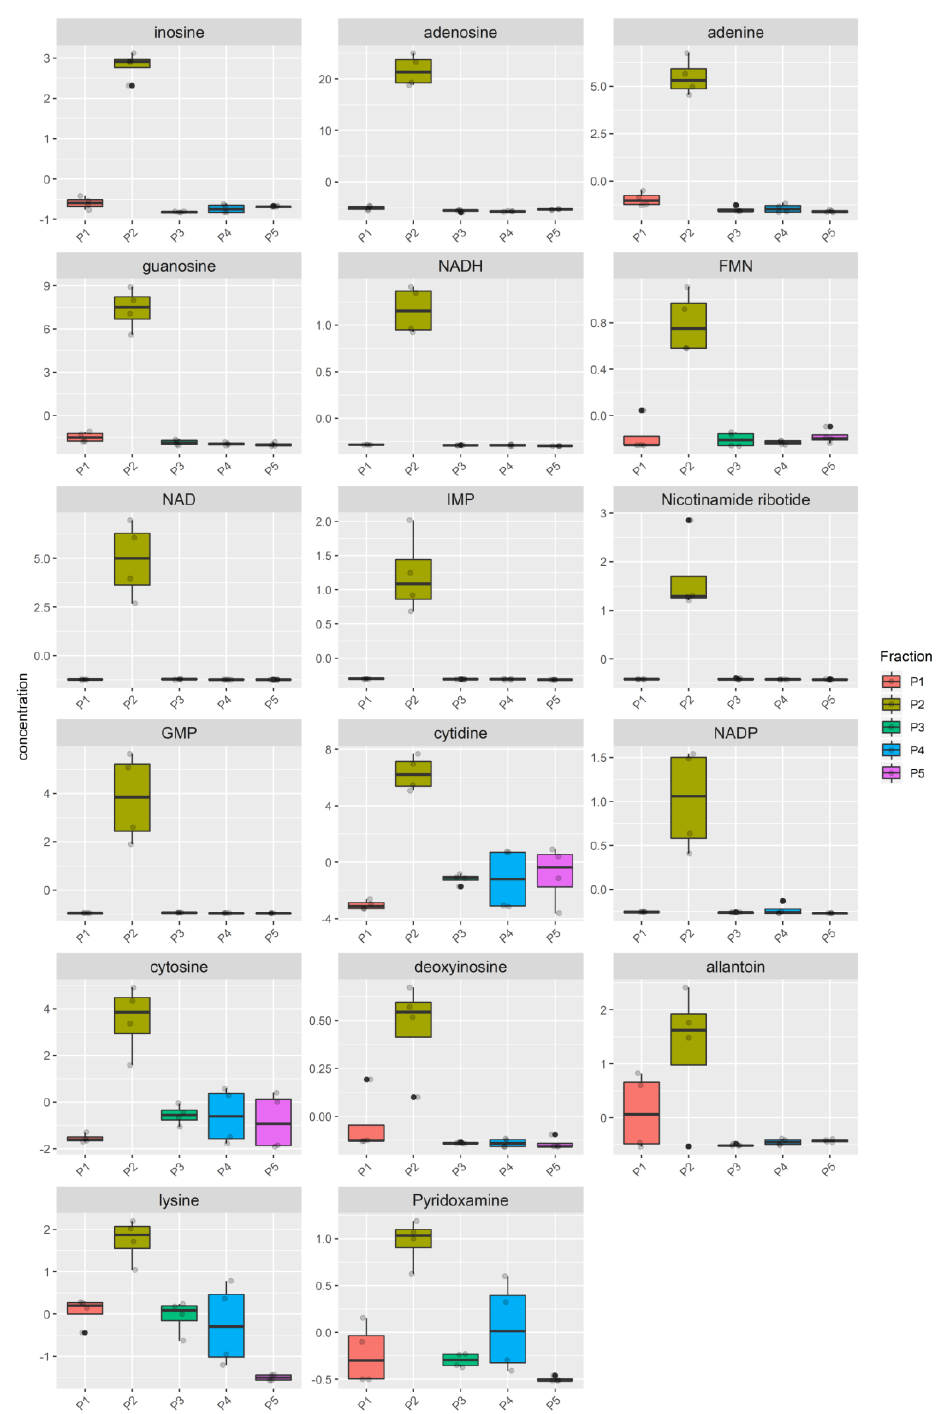
Figure 4. Metabolites enriched in the Bovine P2 fraction. For each fraction, four samples were analyzed. Raw data (quantitative relative ion count) were normalized using the Pareto Scaling normalization and analyzed using the ANOVA test. Only metabolites enriched in the Bovine P2 fraction are reported (FDR p < 0.05). The normalized concentration is reported for each metabolite in the P1, P2, P3, P4, P5 pools. The distribution of the samples is represented by a boxplot. The solid line represents the median, the box reports the interquartile range and the whiskers reports the minimum and maximum value of the distribution. Each sample is represented by a grey point, outliers are reported using a black point.